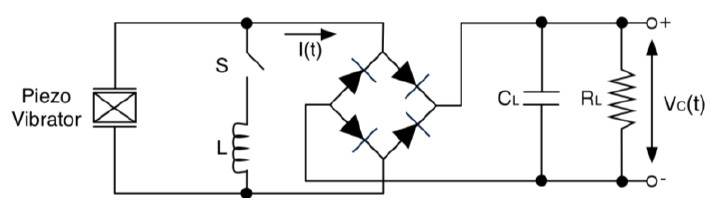
Figure 31. Parallel-SSHI